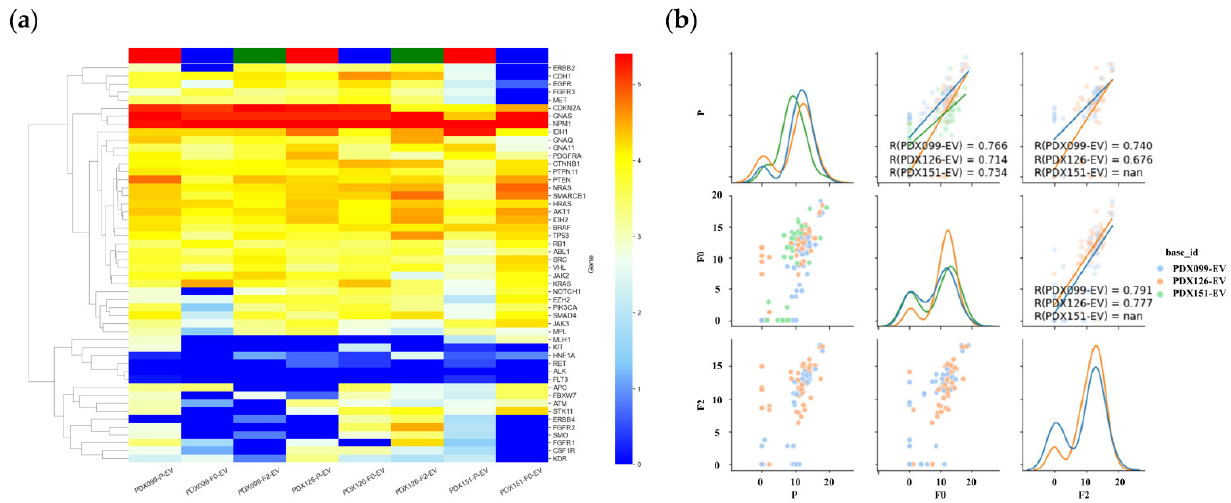
Figure 6. Summary of the relationship between gene expression in the EVs of primary (P-EV) and PDX (F0-EV, F2-EV) tumors based on RNA-seq. ( a ) Clustering and heatmap analysis of mRNA profiling results in P-EV, F0-EV, and F2-EV using the AmpliSeq RNA Cancer Panel. In all cases, gene expression in P-EV was highly correlated with that in F0-EV, F2-EV. ( b ) Pair plot showing gene expression using the AmpliSeq RNA Cancer Panel in 3 PDX (99, 126, and 151) models. The graph in the middle of the left column shows a scatter plot and linear regression of gene expression in the P-EV and F0-EV. The graph at the bottom of the center column shows a scatter plot and linear regression of gene expression in the F0-EV and F2-EV. The lower-left graph shows a scatter plot and linear regression of gene expressions in the P-EV and F2-EV. The diagonal graph shows the KDE. In all cases, the gene expression in P-EV and F0-EV is highly correlated. Gene expression in F0-EV and F2-EV tumors is more highly correlated. The normalized data were converted to base 10 logarithms and z-scores.